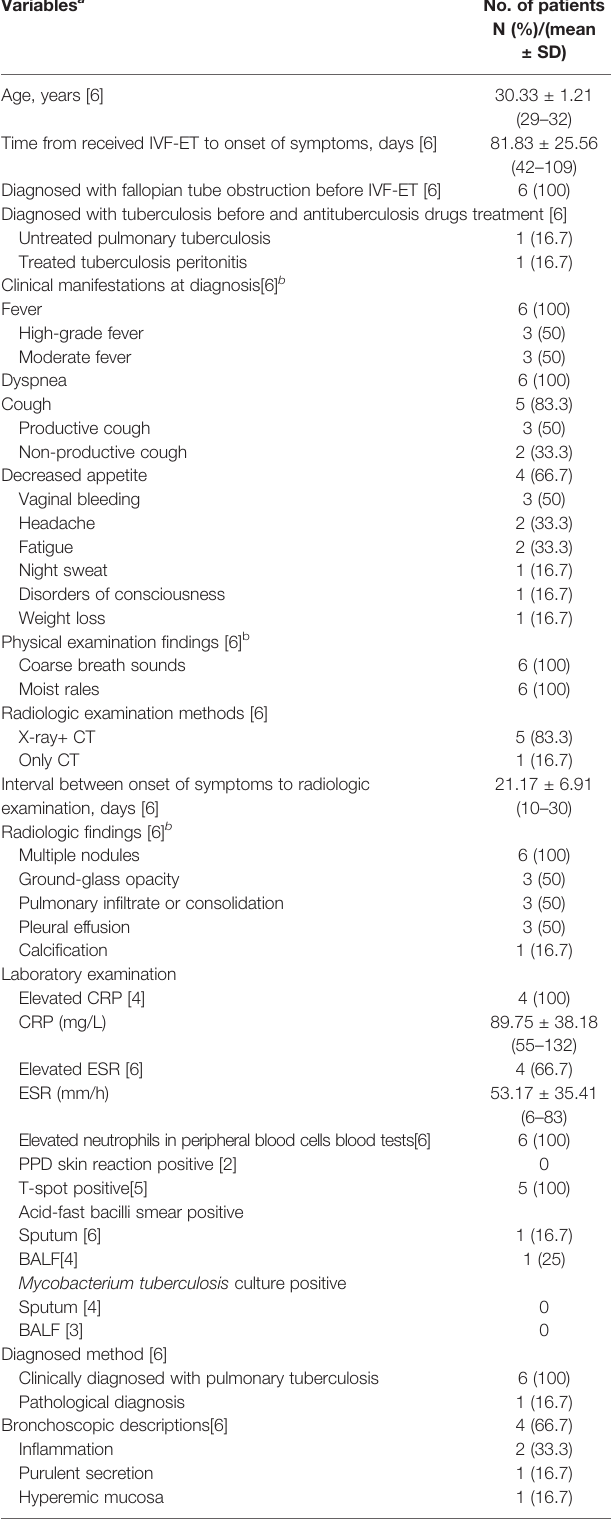
TABLE 1 | Characteristics of six patients diagnosed with miliary pulmonary tuberculosis after IVF-ET in Xiangya Hospital. Variables